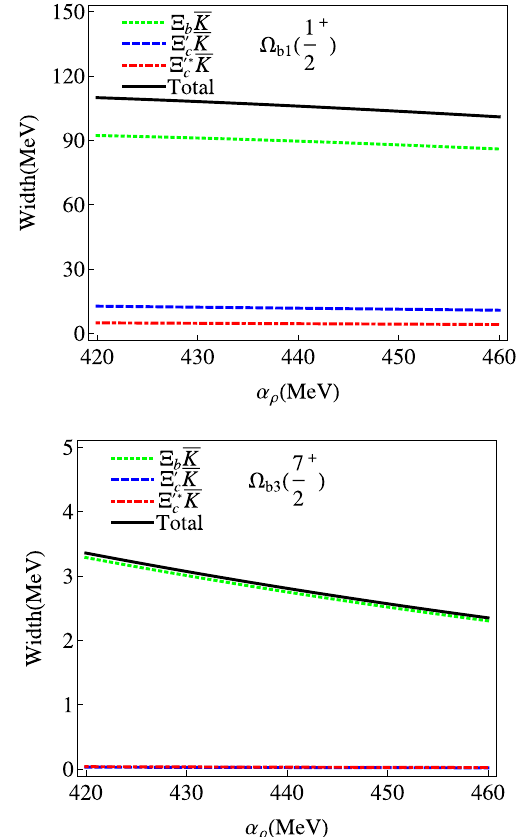
Fig. 7 The dependence of the decay widths on the harmonic oscillator parameter α ρ for the pure J P = 1 / 2 + and 7 / 2 +